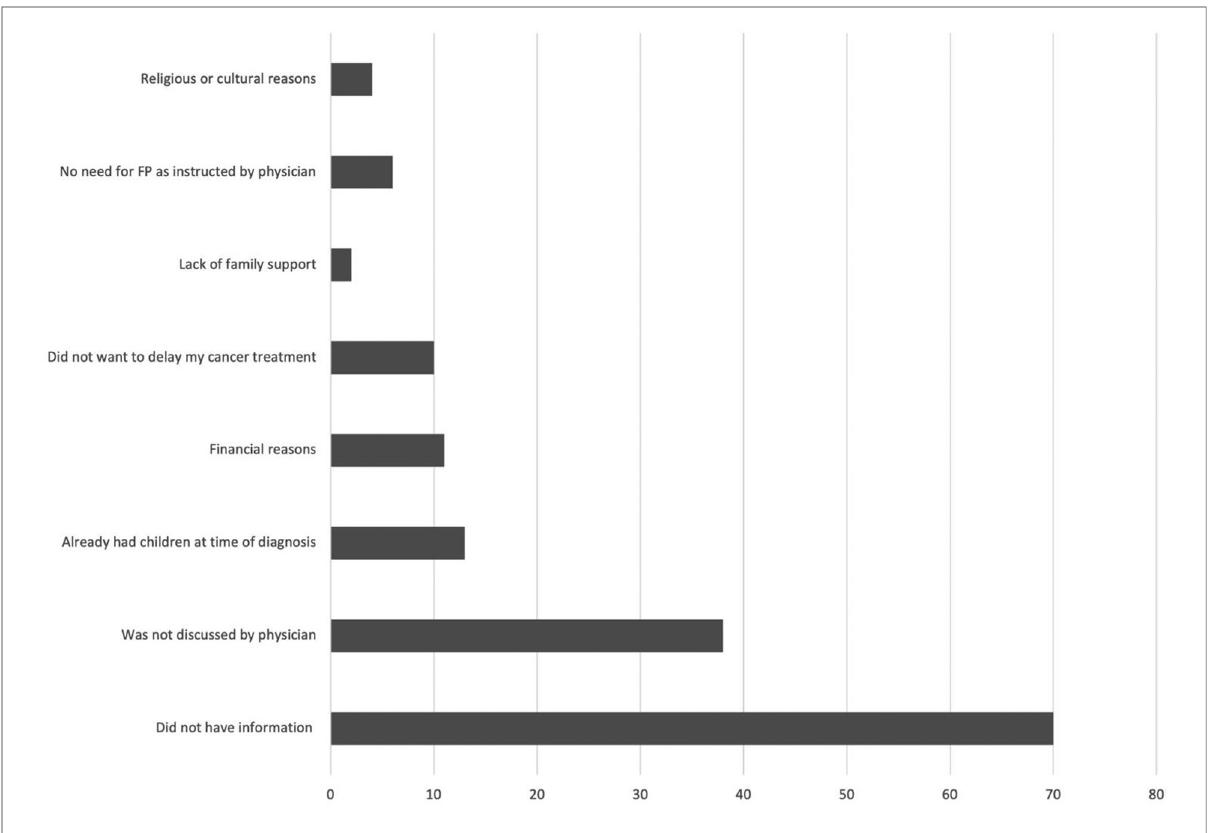
FIGURE 1 Reasons for not undergoing fertility preservation.